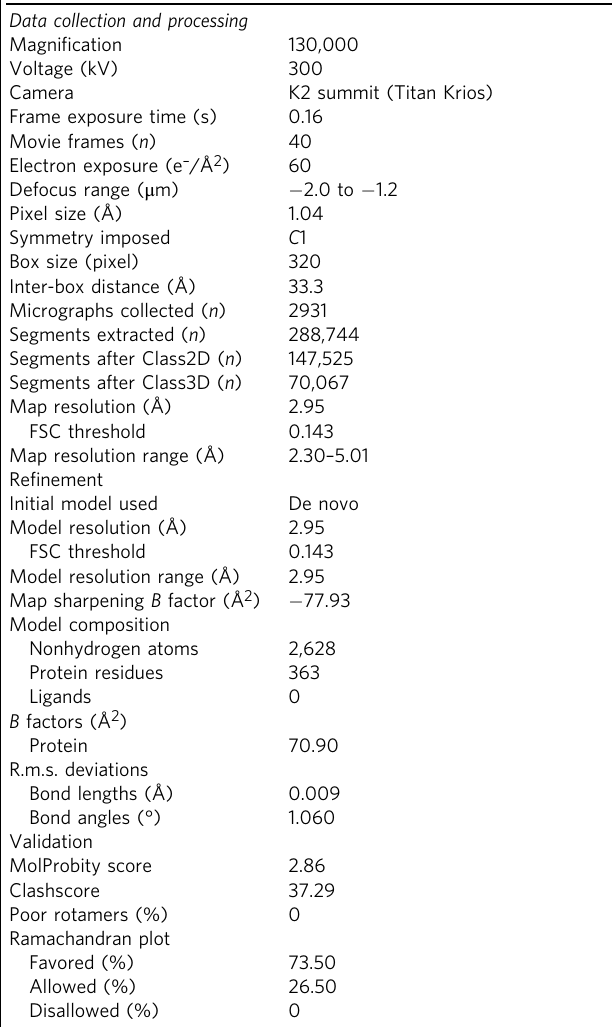
Table 1 Cryo-EM data collection, re fi nement, and validation